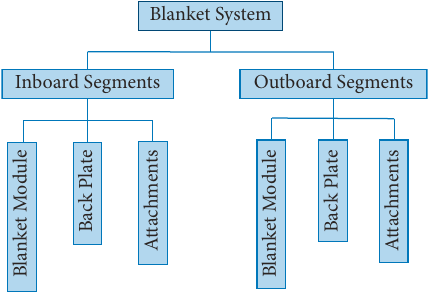
Figure 3: Blanket system decomposition for